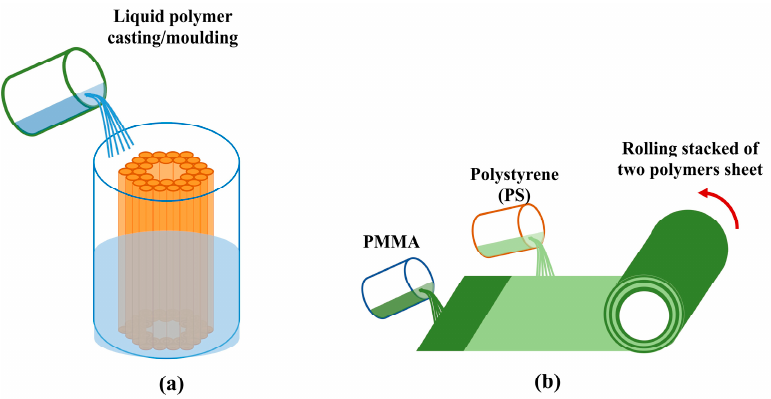
Figure 4. Schematic MPOFs preform fabrication using ( a ) Casting / molding. ( b ) Rolling of planar stack made by solvent deposition.